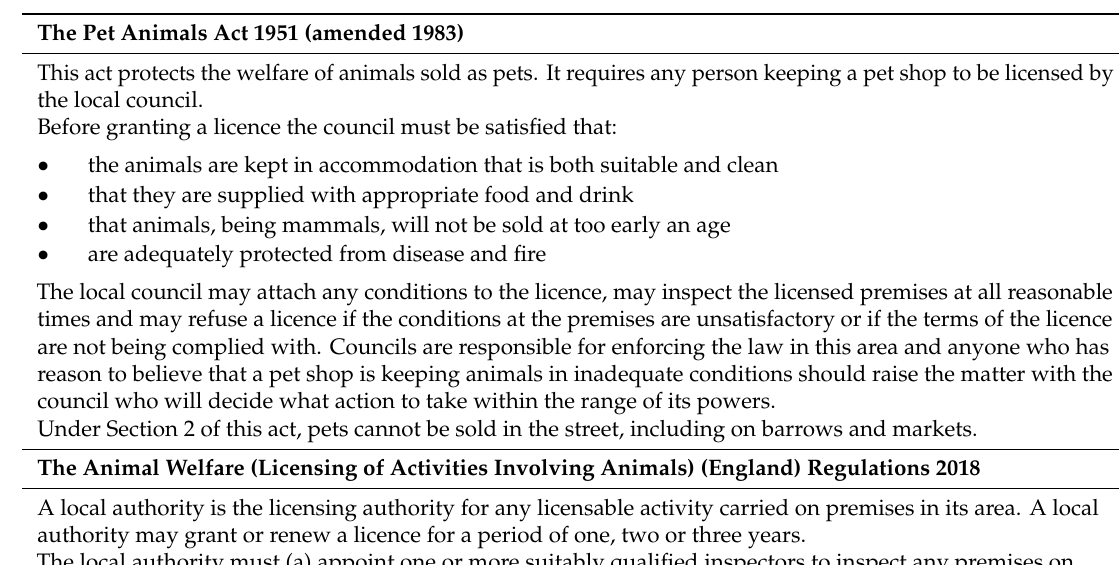
Table A1. Summary of the Pet Animals Act 1951 (amended 1983) and the Animal Welfare (Licensing of